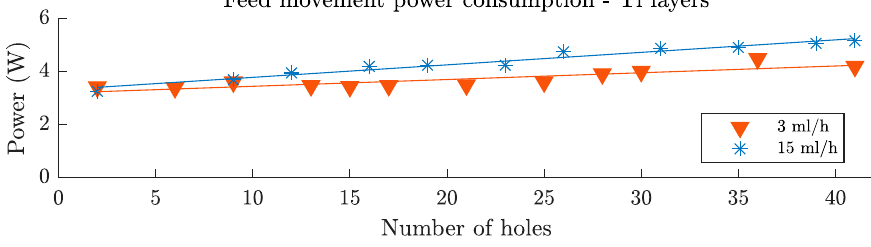
Figure 14. Feed movement power consumption on the Ti layer, after 40 holes, for a Ti/CFRP/Ti stack drilling process.